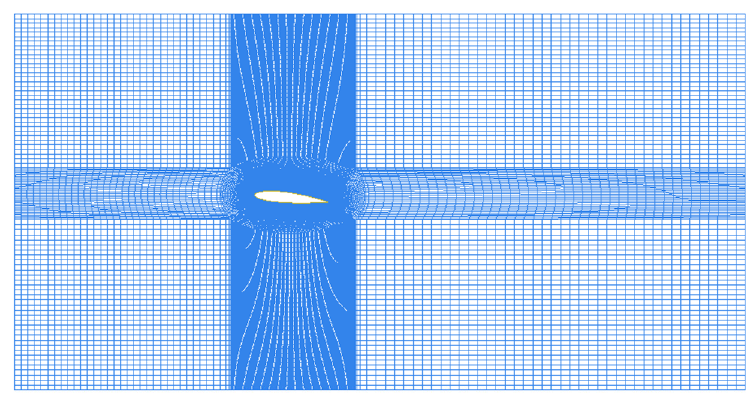
Figure 3. Mesh distribution of the computational domain. Table 1. Computational conditions.